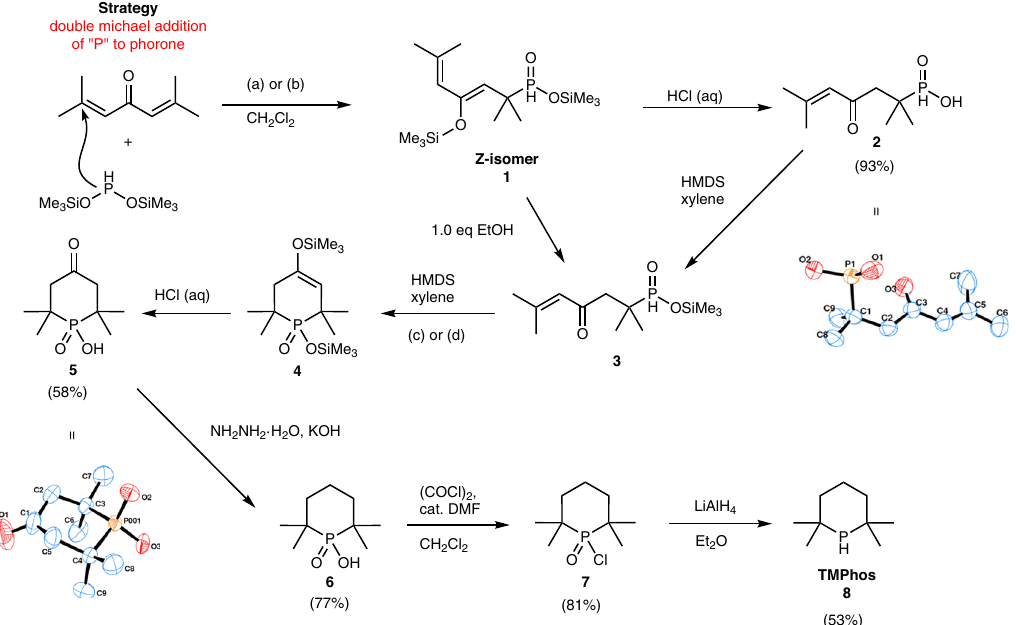
Fig. 4 Synthesis of TMPhos (8). a Hünig ’ s Base/TMSCl/NH 4 H 2 PO 2 , b HMDS/NH 4 H 2 PO 2 , c 125 °C, 72 h, d microwave heating at 220°C, 90